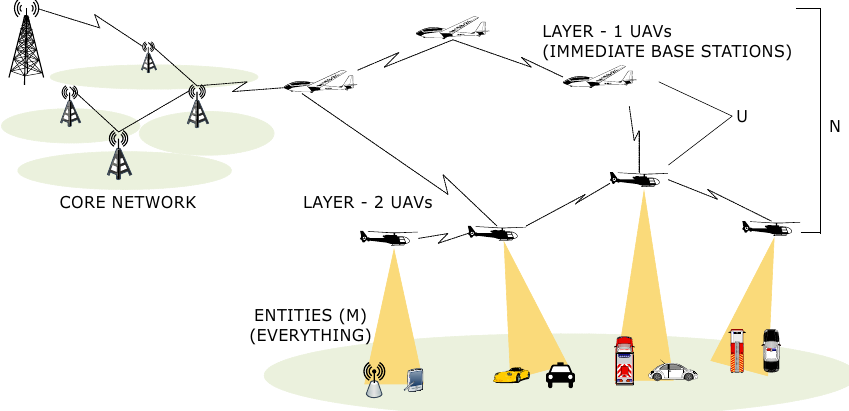
Figure 1. An exemplary illustration of a multi-layer U2X scenario for resource